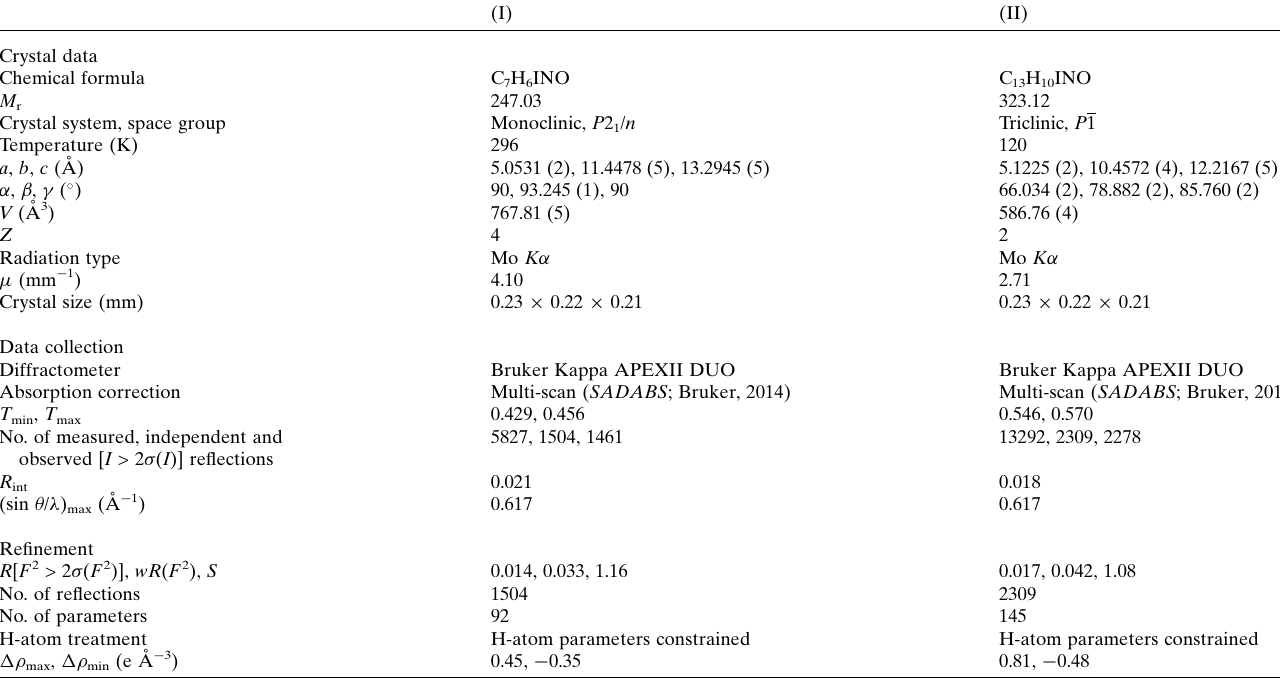
Table 3 Experimental